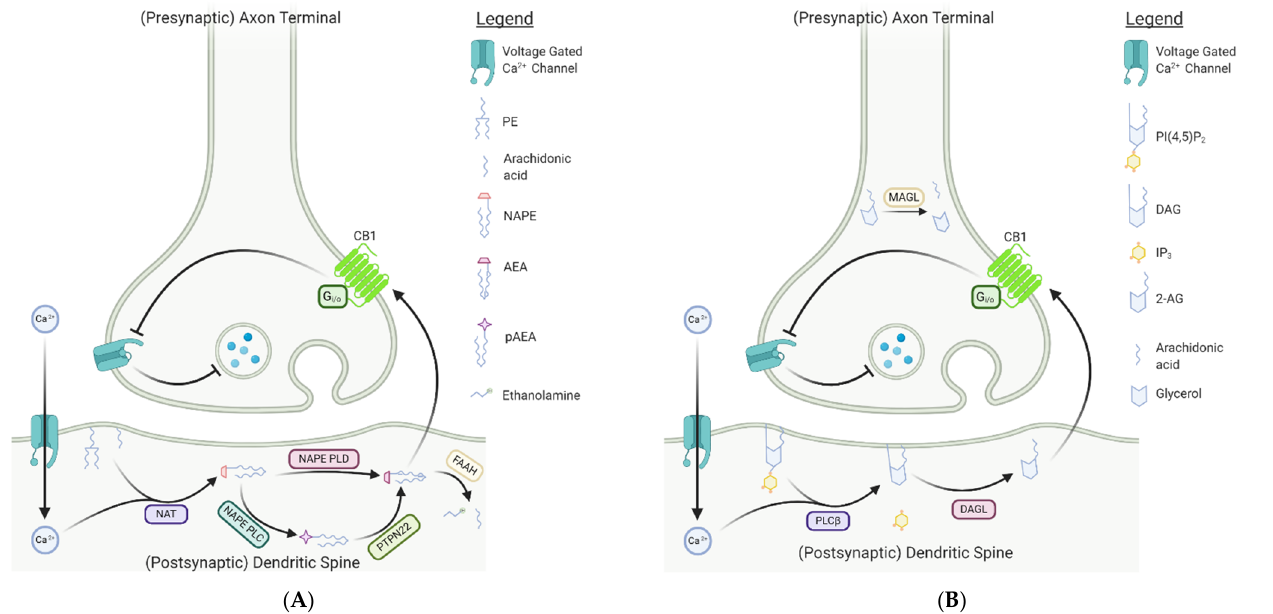
Figure 2. Simplified mechanism of the classical endocannabinoid ligand signaling pathway. ( A ) AEA biosynthesis and mechanism of action. In the post-synaptic neuron, NAT generates NAPE from arachidonic acid and phosphatidylethanolamine (PE) due to a calcium influx following a depolarization event. The most common pathway involves the production of AEA from NAPE through the enzyme NAPE-PLD. However, in the alternative pathway, NAPE-PLC cleaves NAPE to produce pAEA, which is rapidly dephosphorylated via PTPN22 to liberate AEA. NAPE-PLC is the exclusive AEA synthesis pathway in macrophages, key players involved in CNS regeneration. The lipophilic endocannabinoid then crosses the synapse via an unknown mechanism to interact with CB1 receptors on the presynaptic neuron. Activation of CB1 results in inhibition of neurotransmitter release through direct inhibition of voltage gated Ca 2+ channels. AEA is catabolized in the post-synaptic neuron by FAAH to produce AA and ethanolamine. ( B ) 2-AG biosynthesis and mechanism of action. Following depolarization of the post-synaptic neuron, a calcium influx results in activated PLC β which cleaves phos- phatidylinositol 4,5-bisphosphate (PIP 2 ) to produce both inositol triphosphate (IP 3 ) and diacylglycerol (DAG). Subsequently, DAG is hydrolyzed by DAG lipase (DAGL), yielding 2-arachidonyl-glycerol (2-AG). The endocannabinoid then crosses the synapse similarly to AEA to bind to CB1 receptors on the presynaptic neuron. As with AEA, activation of the receptor leads to indirect inhibition of neurotransmitter release. Catabolism of 2-AG occurs in the presynaptic neuron, where the enzyme, monoacylglycerol lipase (MAGL), cleaves 2-AG into glycerol and arachidonic acid (AA). [Created with Bio-Render,